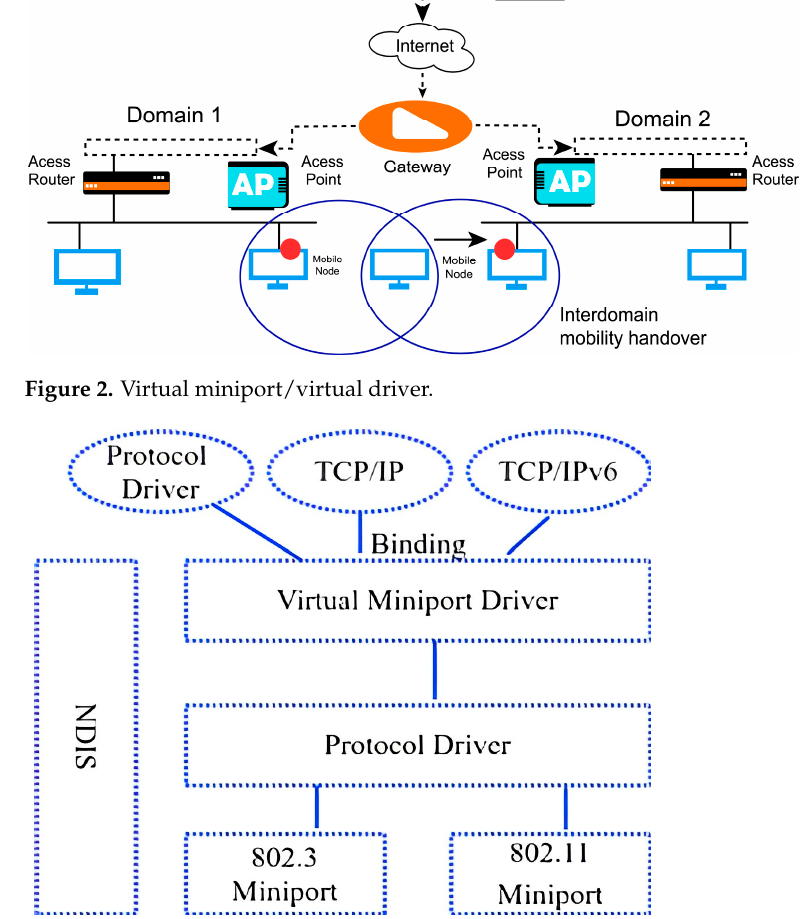
Figure 3. Network driver interface specification.